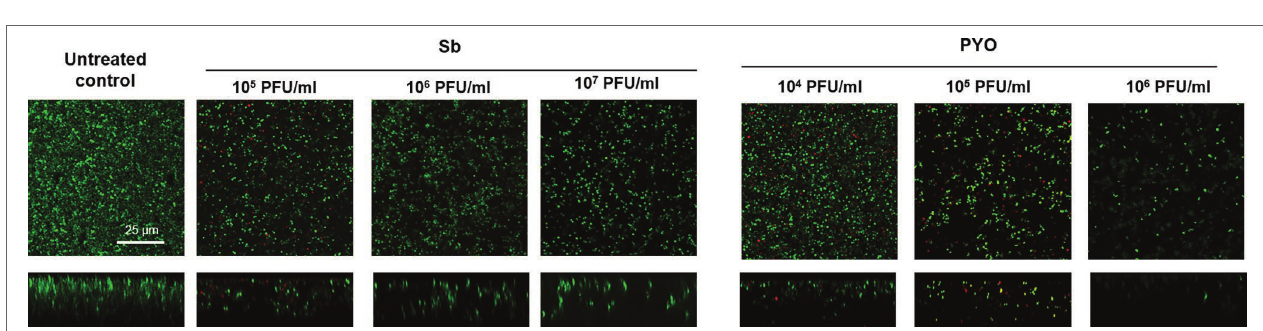
FIGURE 2 | Evaluation of MRSA ATCC43300 biofilm susceptibility to either Sb (A,B) or PYO (C,D) exposure, by isothermal microcalorimetry (A,C) and colony counting (B,D) . Each curve shows the heat produced by viable bacteria attached on beads during 48 h treatment with different titers (ranging from 10 2 to 10 7 PFU/ml) of Sb (A) and PYO (C) , respectively. Histogram represents the mean of CFU number ± SEM of biofilm dislodged MRSA treated/untreated with Sb (B) and PYO (D) . Numbers above curves represent Sb titers (in PFU/ml). GC, growth control (dashed line); NC, negative control.